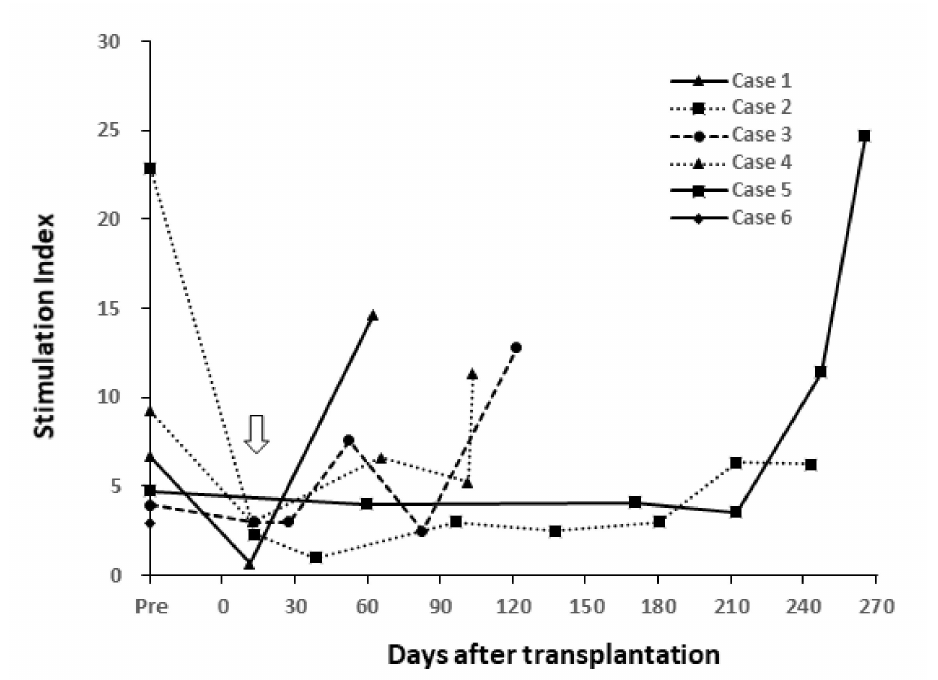
Figure 10. Mixed Lymphocyte Reaction (MLR) stimulation indexes in pre- and post-transplantation. The MLR stimulation index decreased following induction treatment (white arrow). This index increased in conjunction with rejection in cases 1, 4, and 5. The index on POD 1363 in case 1 and on POD 1184 (on delivery) in case 2 were 2.10 and 1.33, indicating that index levels were low (data not